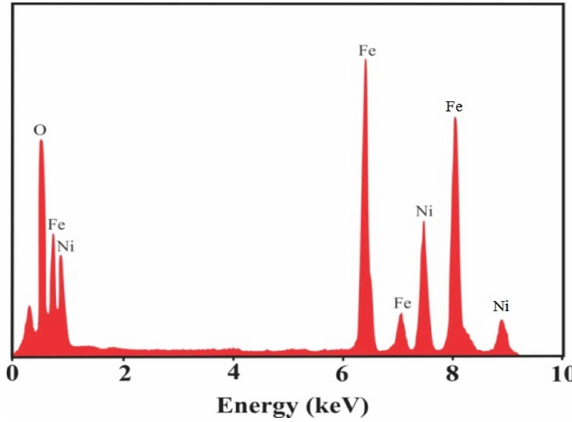
Figure 3. Scanning electron microscope energy dispersive X-ray spectrum of NiFe Effect of solution pH